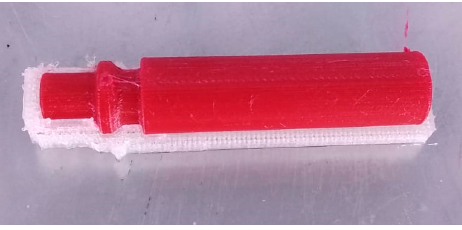
Figure 5. Minitab 17 screenshot where the randomized manufacturing plan is shown.